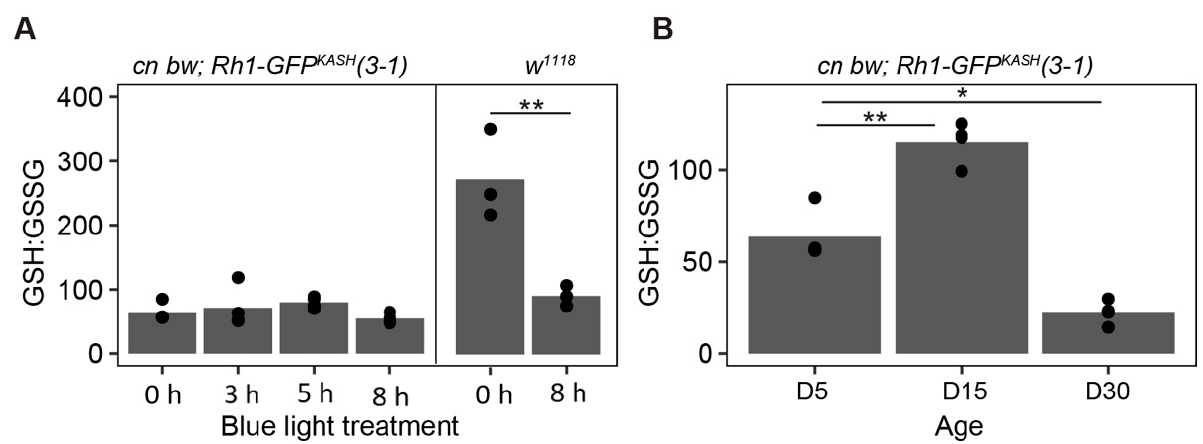
Figure 7. Lower levels of glutathione oxidation following blue light exposure in Rh1-GFP KASH 3–1 flies relative to w 1118 . ( A ) GSH:GSSG ratios in male white-eyed cn bw Rh1-GFP KASH 3–1 or w 1118 flies eyes exposed to 3, 5 or 8 h of blue light at D5 versus untreated control (0 h). Black circles indicate individual biological replicates ( n ≥ 3; 25 eyes per sample), and mean shown by bar height. p -value (** <0.005), t -test. ( B ) GSH:GSSG ratio in male white-eyed cn bw Rh1-GFP KASH 3–1 flies aged to D5, D15, or D30. p -value (* <0.05, ** <0.005), ANOVA with